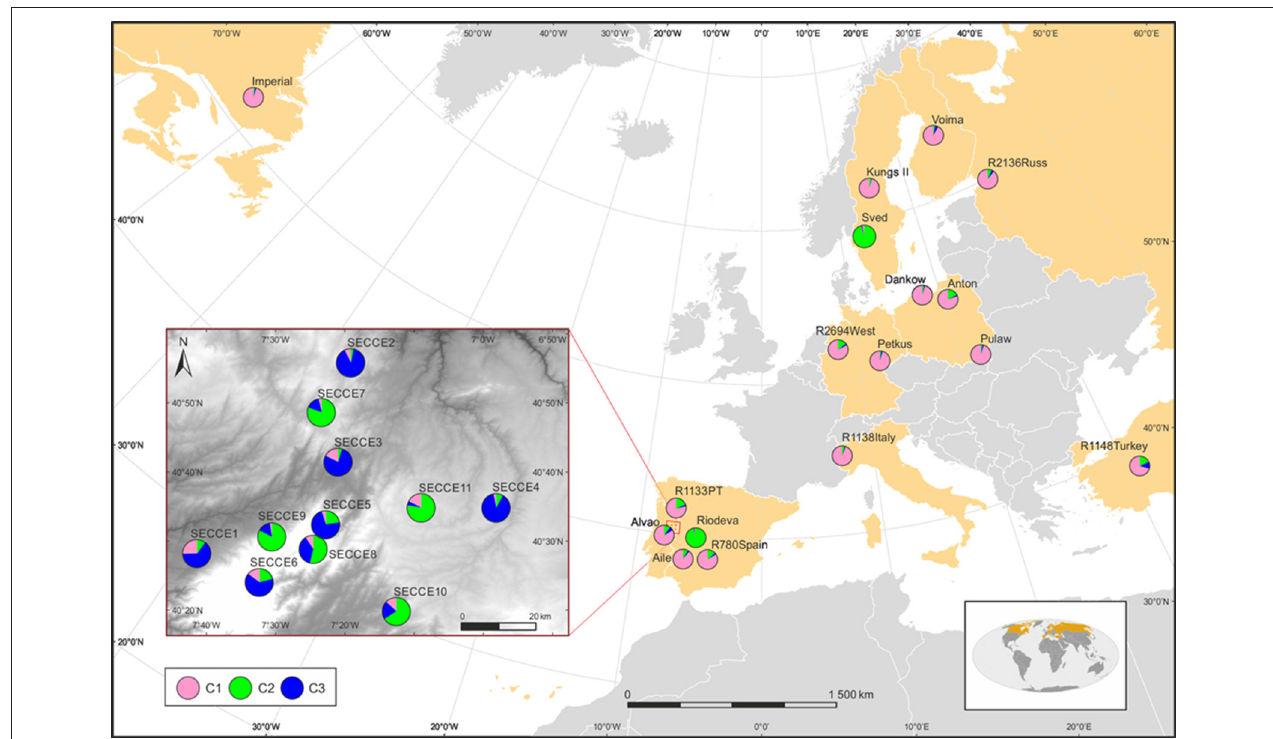
FIGURE 5 | Geographical distribution of clusters according to the K = 3 model in STRUCTURE. Pie charts represent the sum of all individuals’ membership in each cluster at each locality on the map, as identified by the probability assignment defined by STRUCTURE analysis, using ArcGIS 10.3 (ESRI). Population codes are indicated in each pie